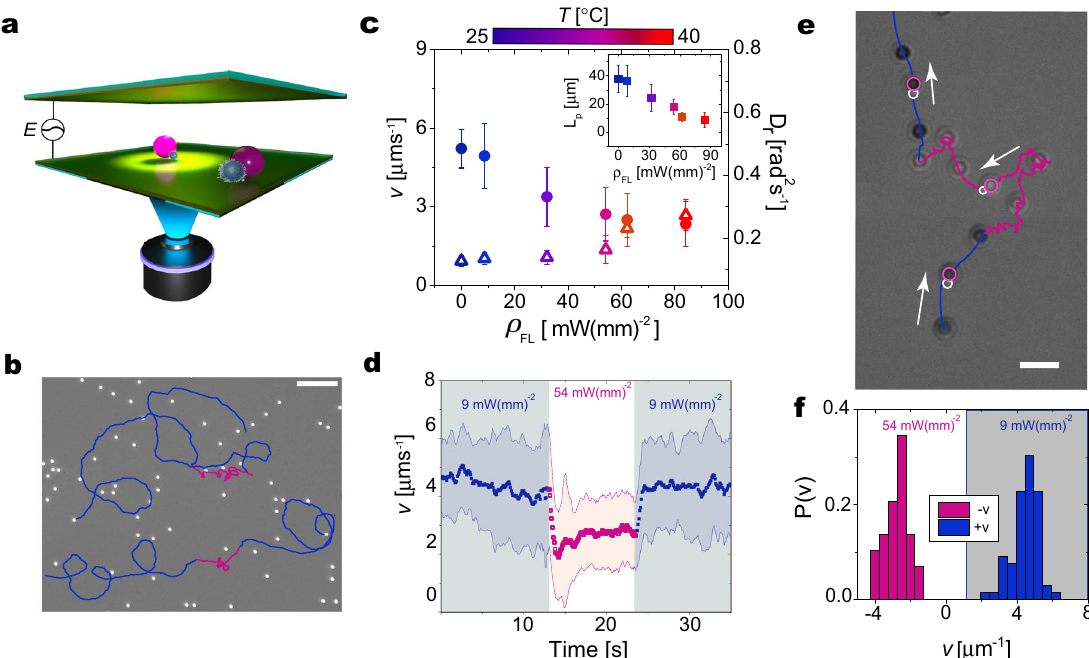
Fig. 2 Experimental realization of adaptive active dumbbells. a Schematic representation of the experimental cell, illustrating the transverse AC electric fi eld E and the local illumination with fl uorescent light, respectively generating motion and causing particle recon fi guration. b Examples of particle trajectories switching ρ FL between 9 (blue trajectory) and 54 mW(mm) − 2 (magenta trajectory). At ρ FL = 54 mW(mm) − 2 , the PS particle heats the microgel above its volume phase transition temperature (VPTT), causing a motility change. c v (solid circles) and D r (open triangles) as a function of illumination power density ρ FL . The inset represents the persistence length ( L p ) of the particles' trajectories as a function of ρ FL . The color scale represents the corresponding temperatures. d Particle velocity as a function of time for two levels of illumination ρ FL = 9 (shaded areas) and 54 (white area) mW (mm) − 2 . Scale bar represents 20 μ m. e Particle trajectory (×63 magni fi cation) showing that at ρ FL = 9 mW(mm) − 2 (blue) the particle swims toward the PS lobe ( + v ), and at ρ FL = 54 mW(mm) − 2 (magenta) it changes direction and swims with the microgel in front ( − v ). The pink and white circles indicate the position of the PS particle and microgel, respectively. f Histogram of particle velocity (45 particles) at low ρ FL (9 mW(mm) − 2 − gray area) and high ρ FL (54 mW(mm) − 2 − white area). Error bars in all cases indicate the standard deviation of the